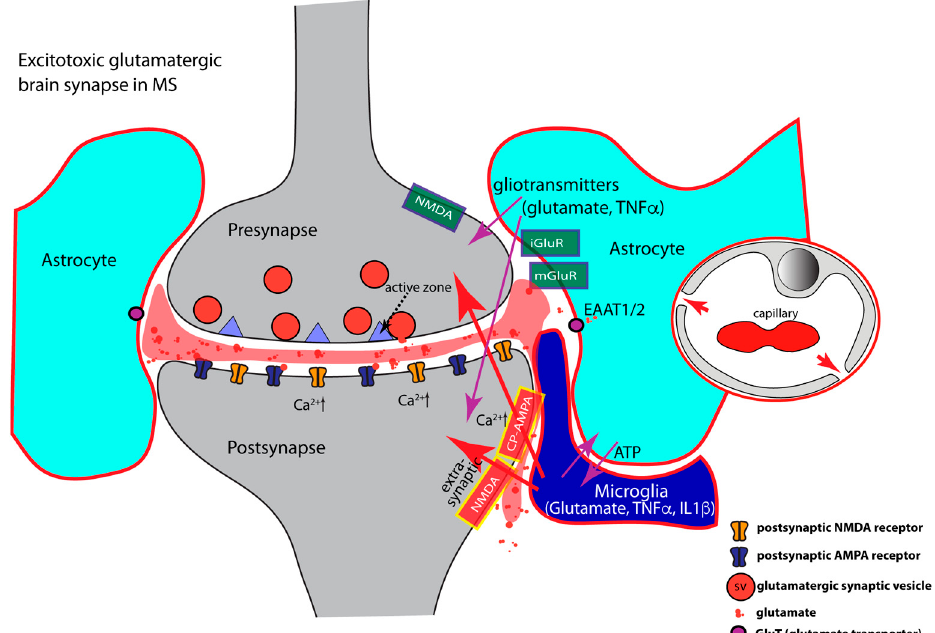
Figure 3. Schematically depicts a brain synapse, as shown in Figure 1, but under neuroinflammatory conditions as in multiple sclerosis (MS). Perisynaptic astrocytes and microglia are strongly activated (encircled in red) and secrete large amounts of inflammatory cytokines. Inflammatory cytokines produce glutamatergic excitotoxicity (see text). Neuroinflammation leads to decreased expression of astrocytic glutamate transporters and to elevated levels of extracellular glutamate (colored in red). Increased extracellular glutamate binds to extrasynaptic glutamate receptors. This initiates a series of deleterious events at the synapse consisting of structural synapse damage, mitochondrial dysfunctions and transcriptional down-regulation of neuroprotective pathways. Synaptic excitotoxicity is further aggravated by increased incorporation of AMPA and NMDA receptors into the postsynaptic membrane, together with a concomitant decrease of inhibitory synaptic transmission (not shown). During neuroinflammation, the integrity of the blood-brain-barrier is compromised and inter-endothelial cell contacts become leaky (indicated by red arrows in the depicted capillary) allowing the entry of blood-borne immune cells into the CNS. Arrows in magenta show interactions between components of the multipartite synapse. Arrows in red denote pathologically activated signaling events during neuroinflammation. Abbreviations: CP-AMPA, Ca 2+ -permeable AMPA receptors; iGluR, ionotropic glutamate receptor; mGluR, metabotropic glutamate receptor; EAAT, excitatory amino acid transporter.